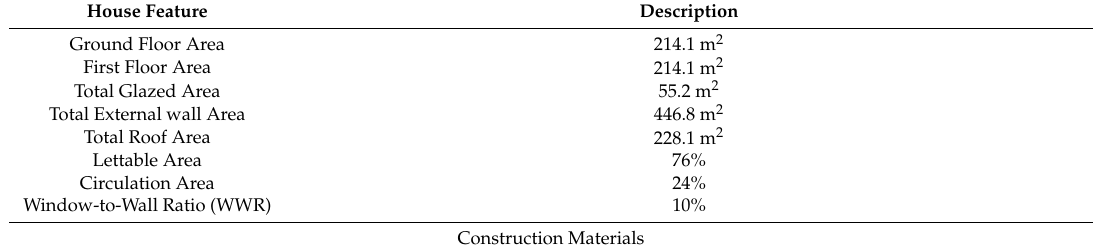
Table 2. Key features of the base